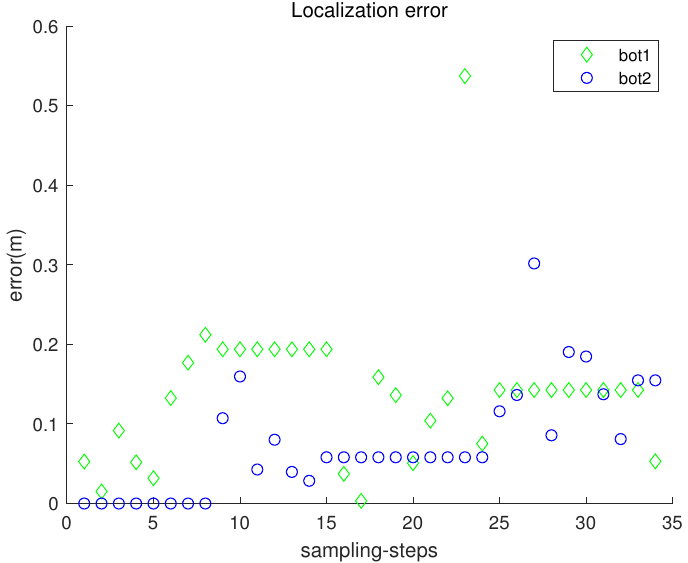
Figure 5. Scenario 1. The localization error (cid:107) r i ( k ) − ˆ r i ( k ) (cid:107) with respect to sampling-stamp k . The orientation direction of the i -th robot at sampling-stamp k is cs ( θ i ( k )) in (2). Let head x represent c ( θ i ( k )) , and let head y represent s ( θ i ( k )) . Figure 6 plots both head x and head y of each robot at each sampling-stamp k . While a robot is settled down, its head x and head y are set as zeros. See that the orientation of a moving robot changes according to the estimated underwater currents.